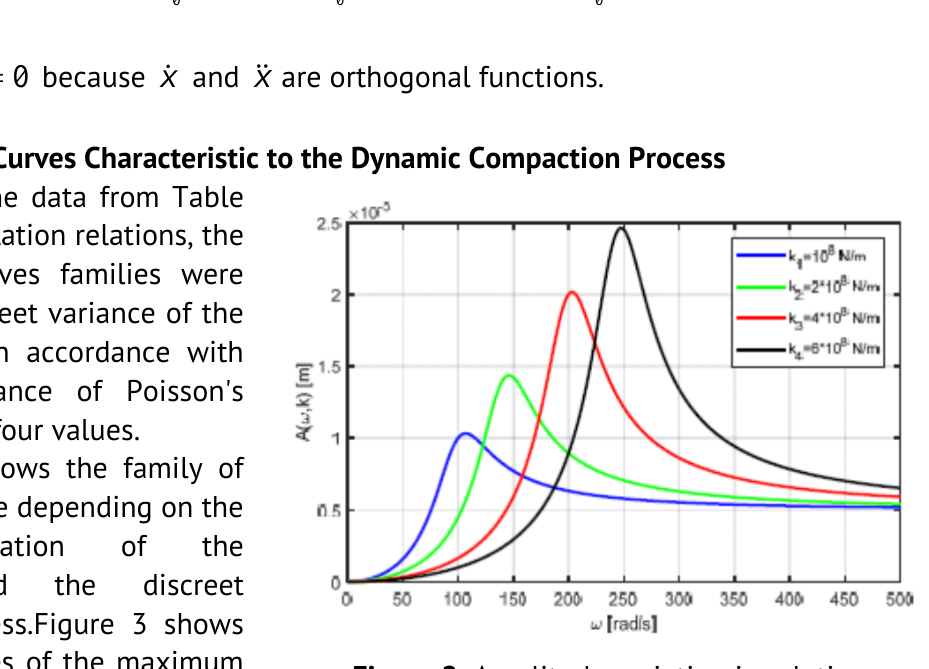
Figure 2. Amplitude variation in relation to (cid:2033) and (cid:1863)